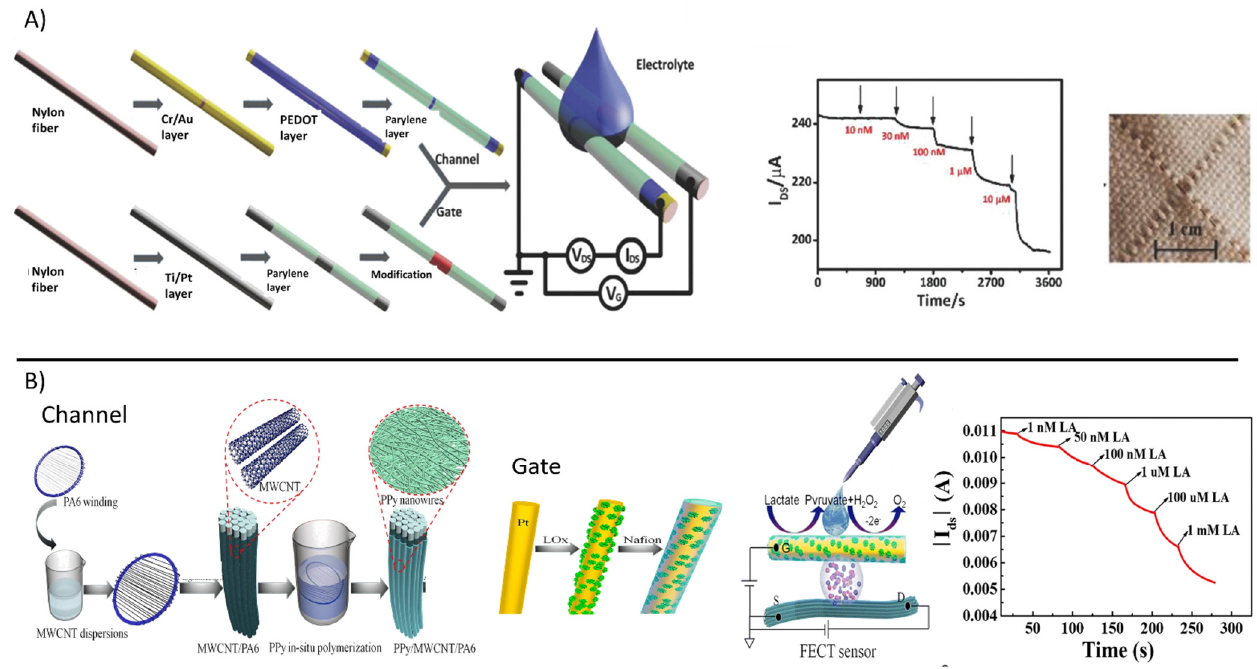
Figure 6. ( A ) Fabrication process of the nylon fiber OECT for glucose sensing. The channel is obtained by the deposition of Cr/Au on a nylon fiber, followed by a PEDOT layer and parylene coating. The gate is obtained by the deposition of Ti/Pt and parylene coating, then modified with chitosan and GOx. Bottom right, graph of the glucose sensor response. Bottom left, photo of the fiber OECT integrated in fabrics. (reproduced from [117] with permission from Elsevier). ( B ) Fabrication process of the fiber based OECT for lactate sensing. From left to right, PA filament is immersed in MWCNT dispersion, (circle zoom shows MWCNT/PA6 filament), then PPy is polymerized in-situ, obtaining a PPy/MWCNT/PA6 fiber channel (circle zoom shows PPy nanowires). The gate electrode is obtained from a Pt wire, coated with LOx and protected with Nafion membrane. Scheme of the fiber based OECT sensor for lactate sensing. Sensors response to lactate additions. Reprinted by permission from [119], Copyright (2021) Springer Nature .